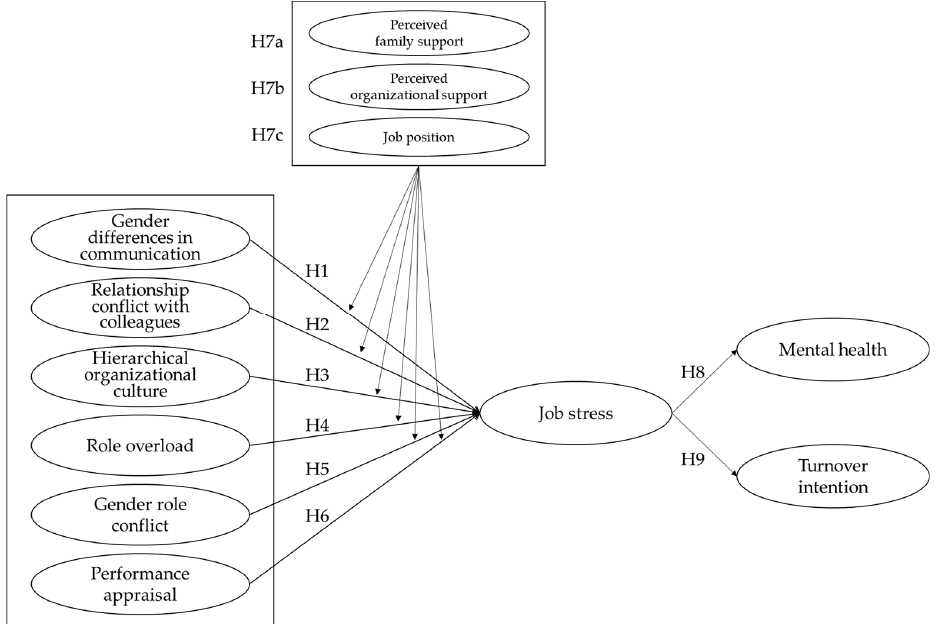
Figure 1. Research model. Hypothesis 1 (H1). Gender differences in communication have a positive (+) effect on male flight attendants’ job stress; Hypothesis 2 (H2). Relationship conflict with colleagues has a positive (+) effect on male flight attendants’ job stress; Hypothesis 3 (H3). Hierarchical organizational culture has a positive (+) effect on male flight attendants’ job stress; Hypothesis 4 (H4). Role overload has a positive (+) effect on male flight attendants’ job stress; Hypothesis 5 (H5). Gender role conflict has a positive (+) effect on male flight attendants’ job stress; Hypothesis 6 (H6). Performance appraisal has a positive (+) effect on male flight attendants’ job stress; Hypothesis 7a (H7a). Male flight attendants’ job stress varies depending on perceived family support; Hypothesis 7b (H7b). Male flight attendants’ job stress varies depending on perceived organizational support; Hypothesis 7c (H7c). Male flight attendants’ job stress varies depending on job position; Hypothesis 8 (H8). Job stress has a negative ( − ) effect on male flight attendants’ mental health; Hypothesis 9 (H9). Job stress has a positive (+) effect on male flight attendants’ turnover intention. 3.2. Measurement Gender differences in communication were assessed using four items from the Down and Hazen Communication Satisfaction Questionnaire (CSQ) [45]. The items on relationship conflict with colleagues comprised four items, using the scale developed by Jehn [46]. Based on Kimberly and Quinn’s theory [47], hierarchical organizational culture consisted of four items. The questionnaire on role overload was reconstructed into four items based on previous studies [48,49]. Gender role conflict was measured using four items based on the Gender Role Conflict Scale developed by O’Neil et al. [50]. Four items were used to assess performance appraisals, based on Lee’s research questionnaire [51]. Based on the research of Quick and Quick [52], the measurement of job stress consisted of four items reconstructed through focus interviews with male flight attendants. The Psycho-Social Well-being Index [53] was used to assess mental health, which consisted of four items. In terms of turnover intention, four items were selected using Mobley’s measurement tool [54]. Four items on perceived family support were created using Kang’s family support measurement tool [55]. The measurement of perceived organizational support consisted of four items, using Yoo’s items [56], which were adapted from the content developed by Eisenberger et al. [57]. All measurement items were assessed using a 5-point Likert scale ranging from 1 (not at all) to 5 (very much).